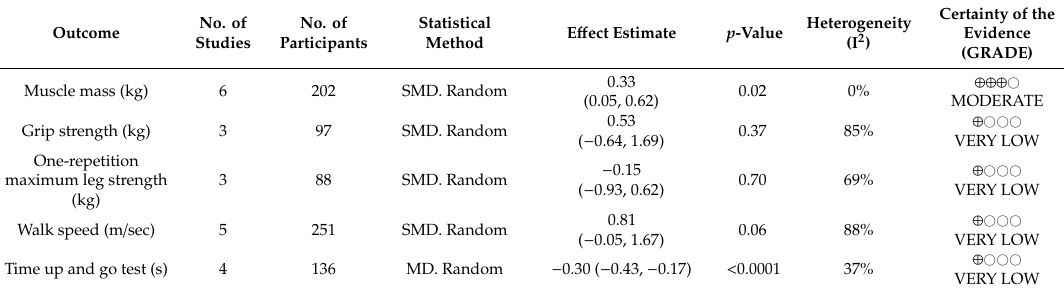
Figure 3. Summarized risk-of-bias graph for all included studies. Table 2. Summary effects of n-3 PUFAs on the outcomes of interest among the included studies and quality evidence of the Grading of Recommendations Assessment, Development and Evaluation (GRADE).